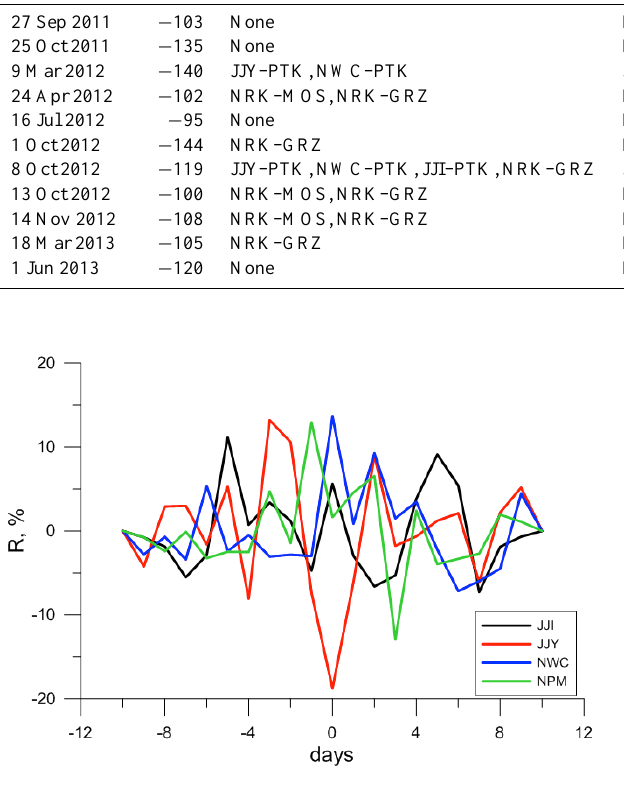
Figure 5. Cross-covariance functions for the average residual am- plitude at nighttime of the signals received in Petropavlovsk- Kamchatsky and MaxDst indexes calculated in the interval ± 10 days. Y axis is the correlation